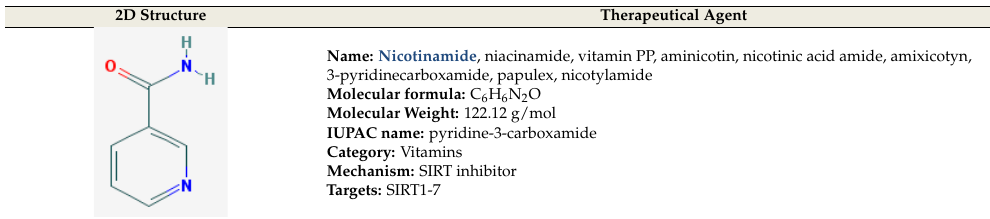
Table 4. Potential sirtuin (SIRT) modulators.